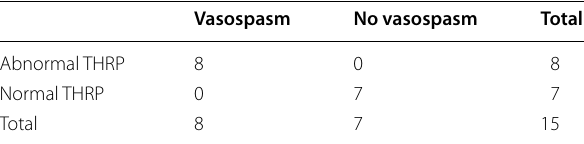
Table 3 Abnormal THRT can predict asymptomatic vasos- pasm development